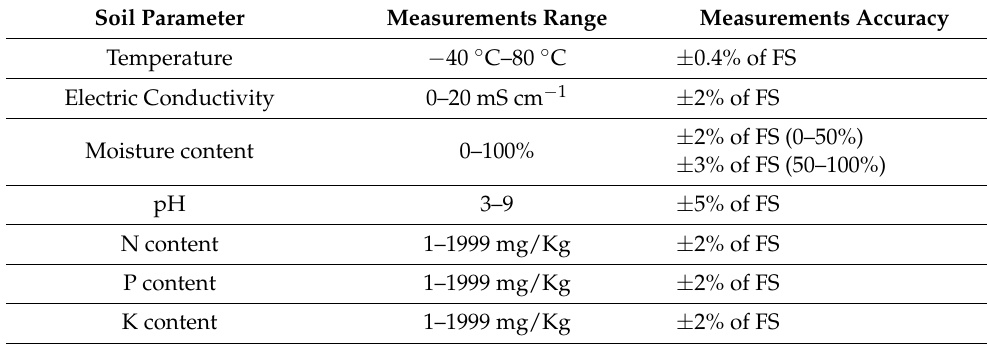
Table 4. Time delay reflectometry integrated soil sensor